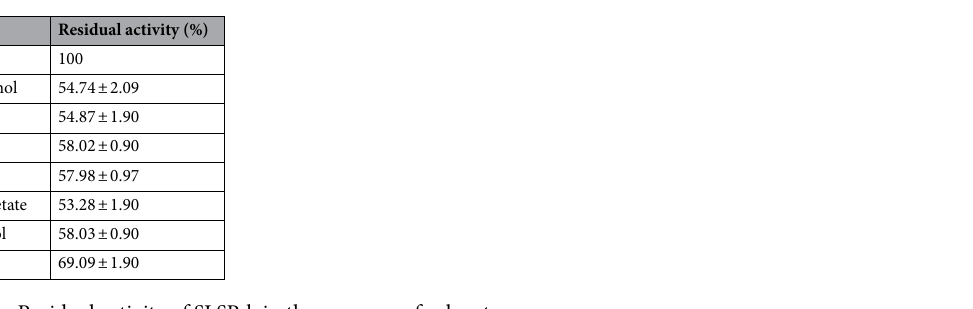
Table 4. Residual activity of SLSP-k in the presence of